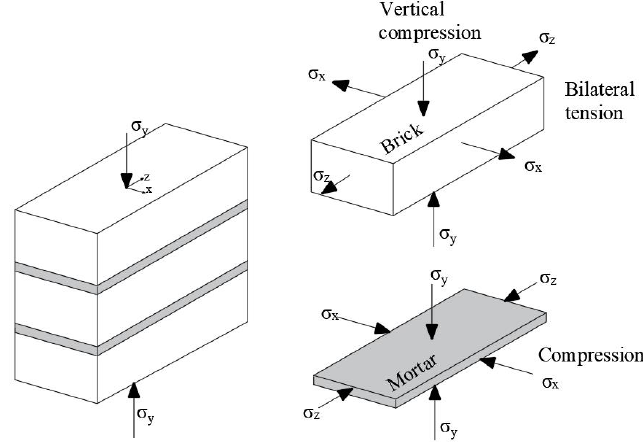
Figure 15. State of stress of brick and mortar in the masonry prism.